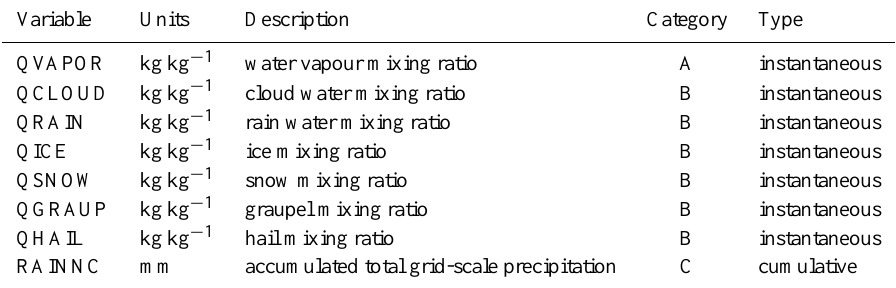
Table 2. WRF output variables describing the atmospheric water cycle. The variables are divided into three categories whether they represent uncondensed water (A), condensed water particles (B) or precipitated water (C). RAINNC is the sum of all the available types of precipitation that each microphysical scheme is able to compute and might include rain, snow, graupel and hail. Variable Units Description Category QVAPOR kg kg − 1 water vapour mixing ratio A instantaneous QCLOUD kg kg − 1 cloud water mixing ratio B instantaneous QRAIN kg kg − 1 rain water mixing ratio B instantaneous QICE kg kg − 1 ice mixing ratio B instantaneous QSNOW kg kg − 1 snow mixing ratio B instantaneous QGRAUP kg kg − 1 graupel mixing ratio B instantaneous QHAIL kg kg − 1 hail mixing ratio B instantaneous RAINNC mm accumulated total grid-scale precipitation C